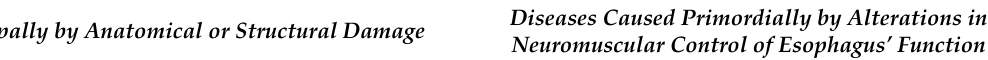
Table 1. Diseases of the esophagus may require dietary intervention or specific nutritional